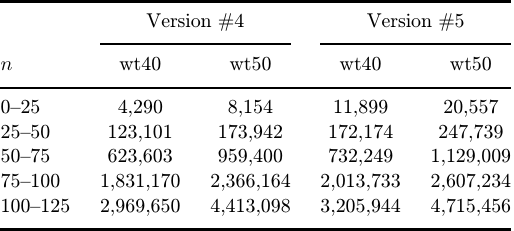
Table 2. AIT Version #4 and Version #5